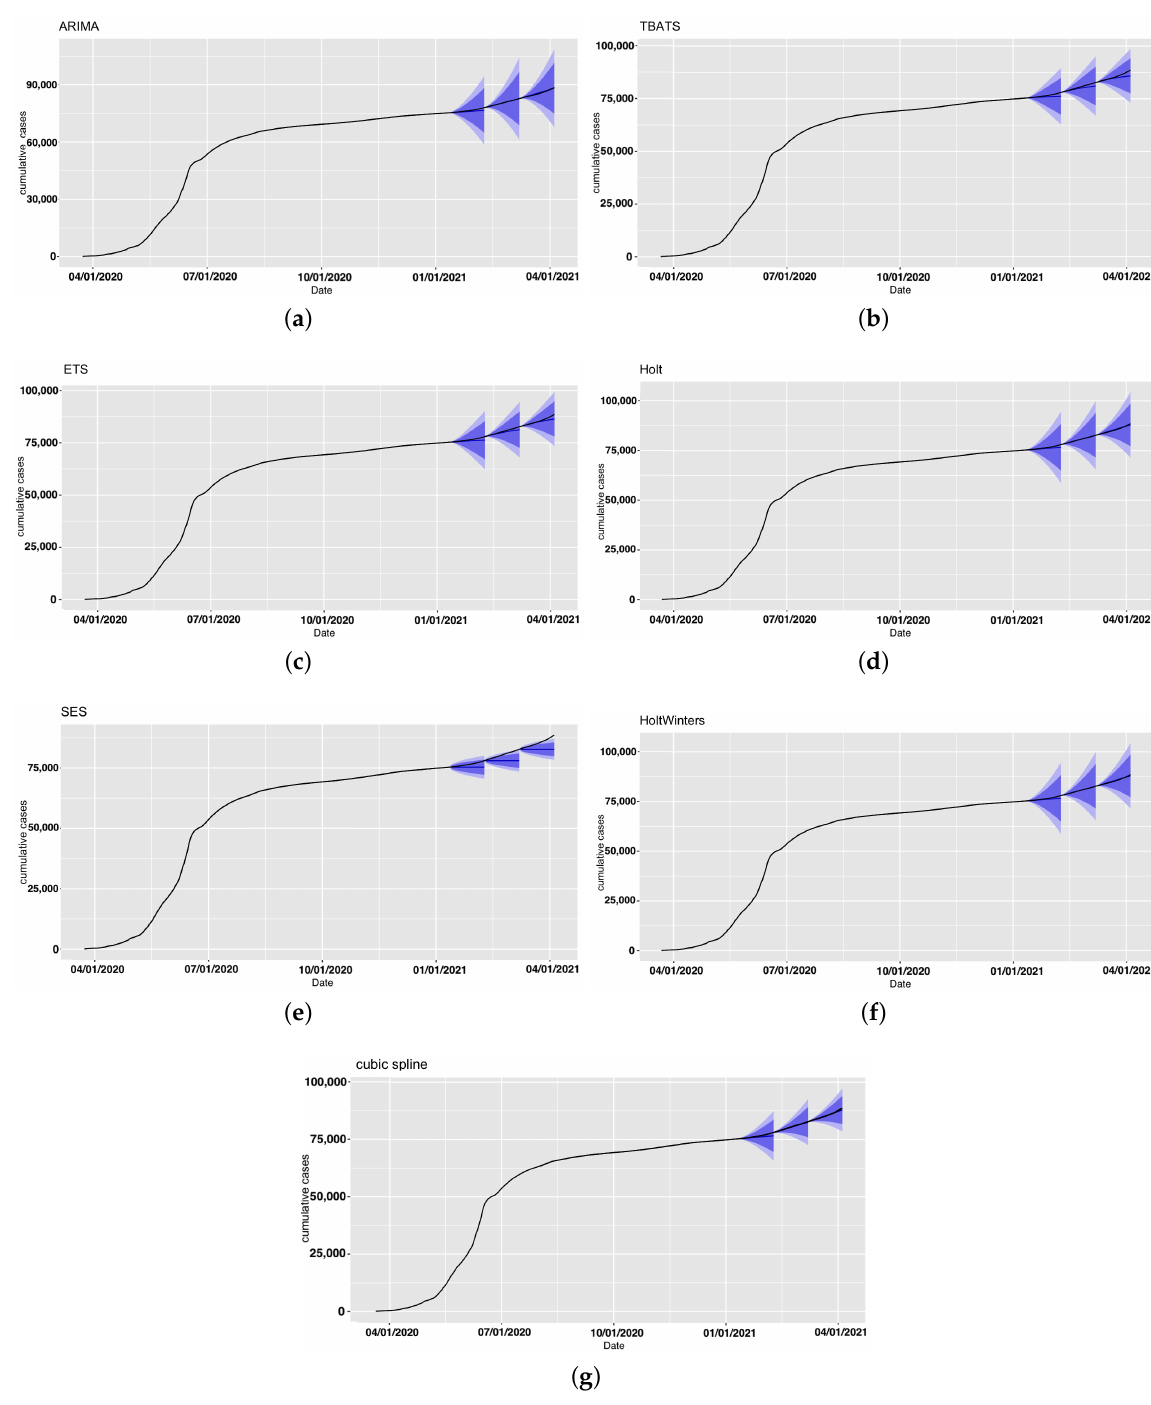
Figure 8. Forecast confirmed cases in Riyadh for all models with prediction intervals (in blue). ( a ) ARIMA, ( b ) TBATS, ( c ) ETS, ( d ) Holt, ( e ) SES, ( f ) HoltWinters, and ( g ) cubic